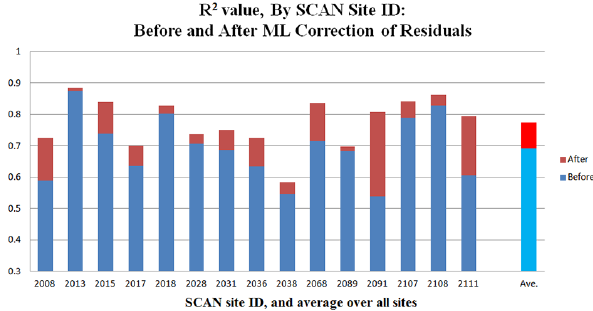
Figure 2. Improvements from machine learning (KNN) models of